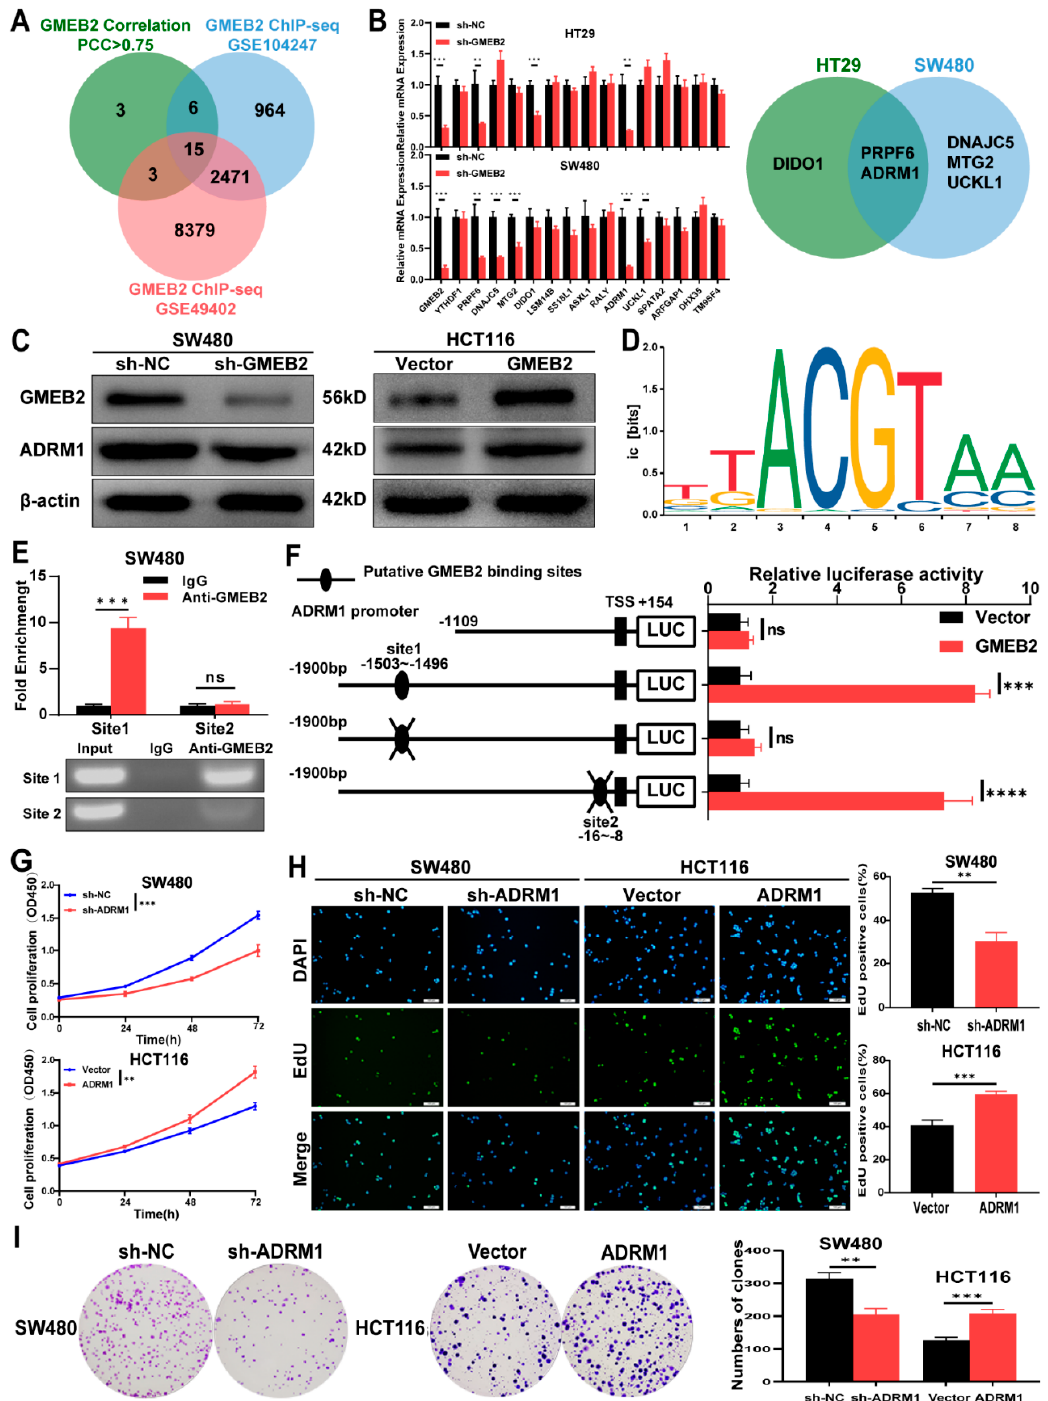
Figure 3. ADRM1, a direct transcriptional target of GMEB2, effectively facilitates CRC cell proliferation. ( A ) Venn diagram of GMEB2 ChIP-seq data (GSE104247, GSE49402) and GMEB2 correlation